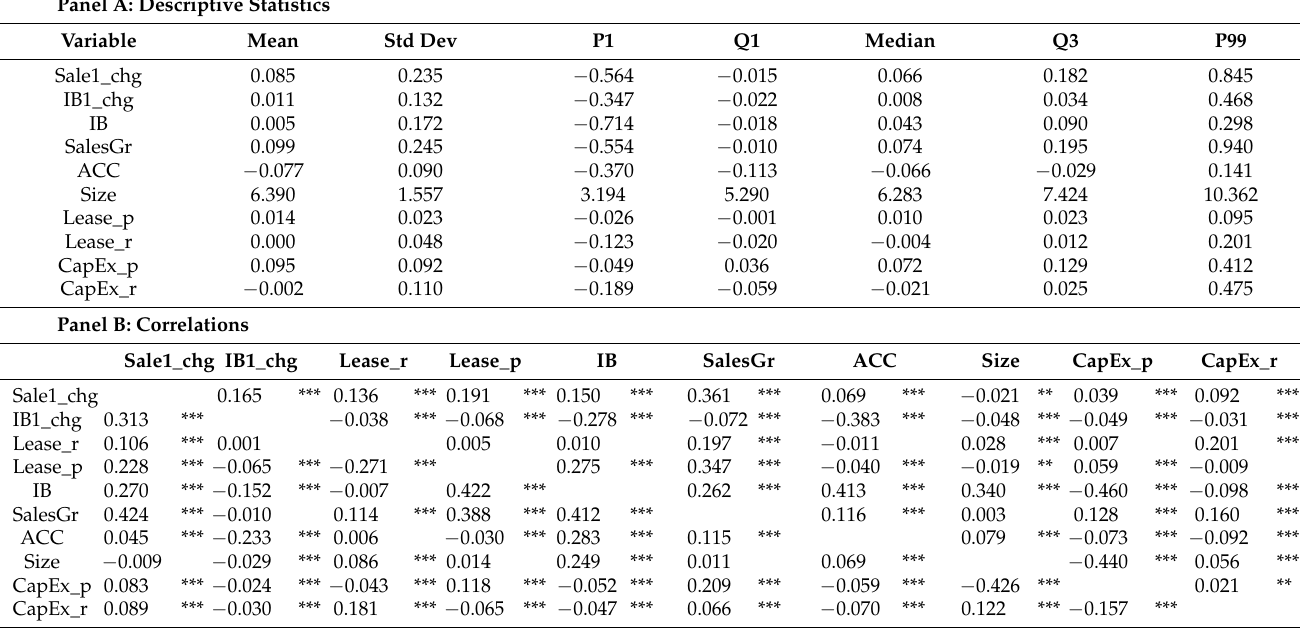
Table 6. Future Performance